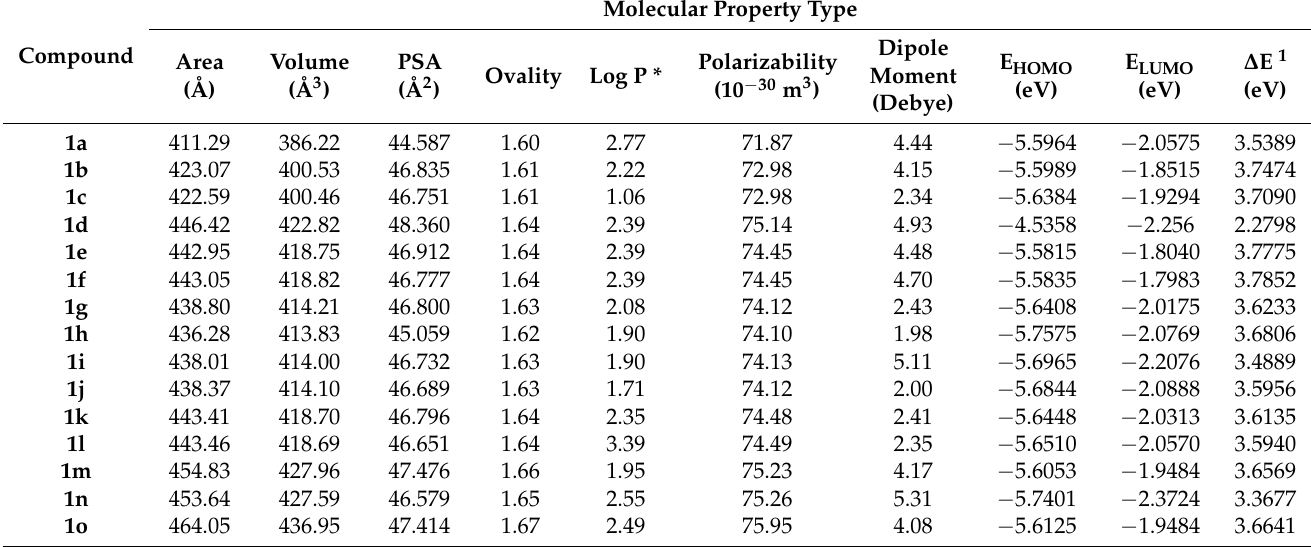
Table 2. Molecular properties with respect to designed chemical compounds, generated by Spartan 14 software.